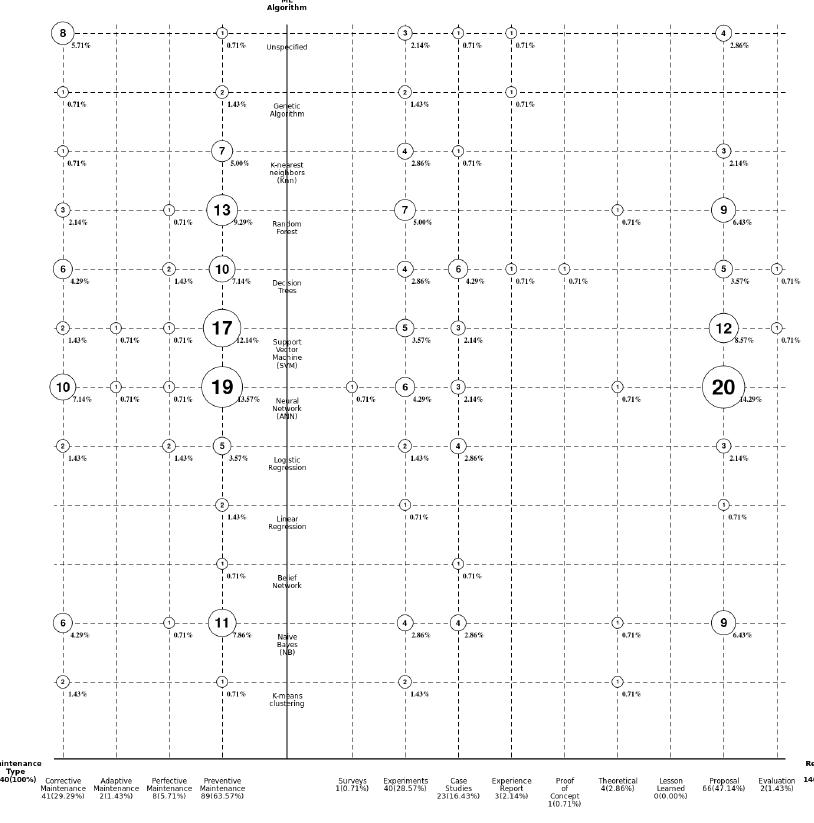
Figure 17. Distribution of studies by type of maintenance, research, and ML algorithm.